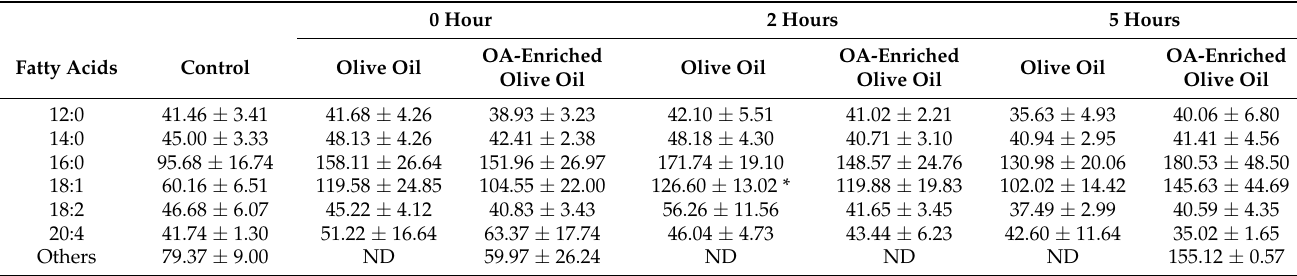
Figure 5. Oil red O microphotographs of THP-1 macrophages incubated for 48 h in the presence or absence (control) of TRLs obtained before, and at 2 and 5 h after the consumption of the olive oils. ( a ) Control; ( b ) 0 h TRL; ( c ) 2 h TRL; ( d ) 5 h TRL. Table 1. Intracellular fatty acid composition ( µ g/mg cell protein) of total lipids in THP-1 macrophages after incubation with TRLs derived from two different olive